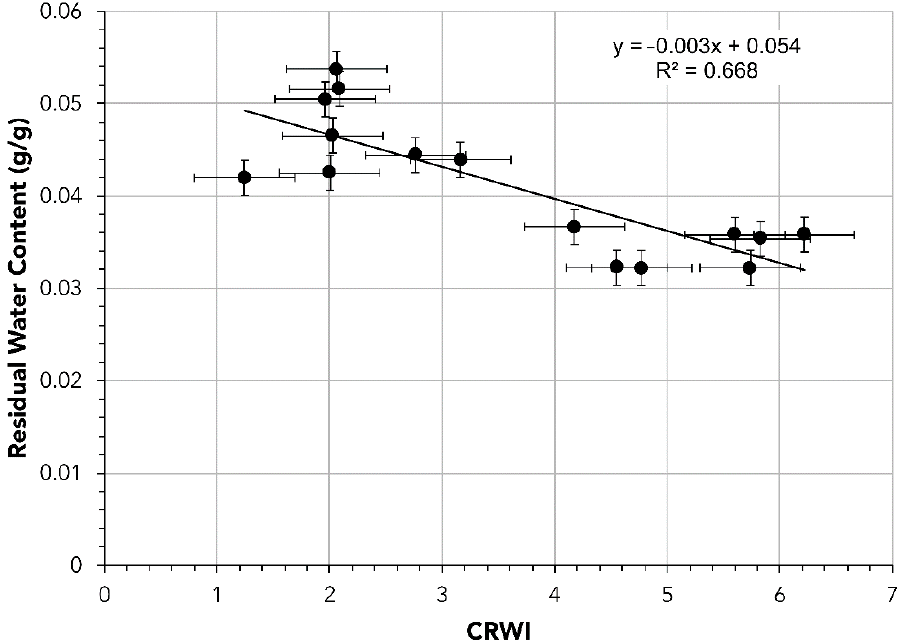
Figure 8. Continuum removed water index (CRWI) versus residual water content. Samples that have enhanced residual water content after air drying showed lower CRWI in the field. p < 0.001